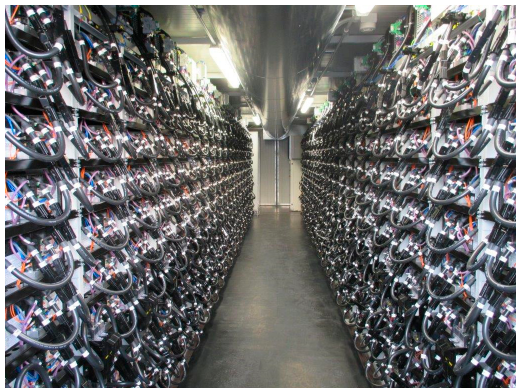
Figure 2. Racks for battery strings, installed inside an air-conditioned cabinet.